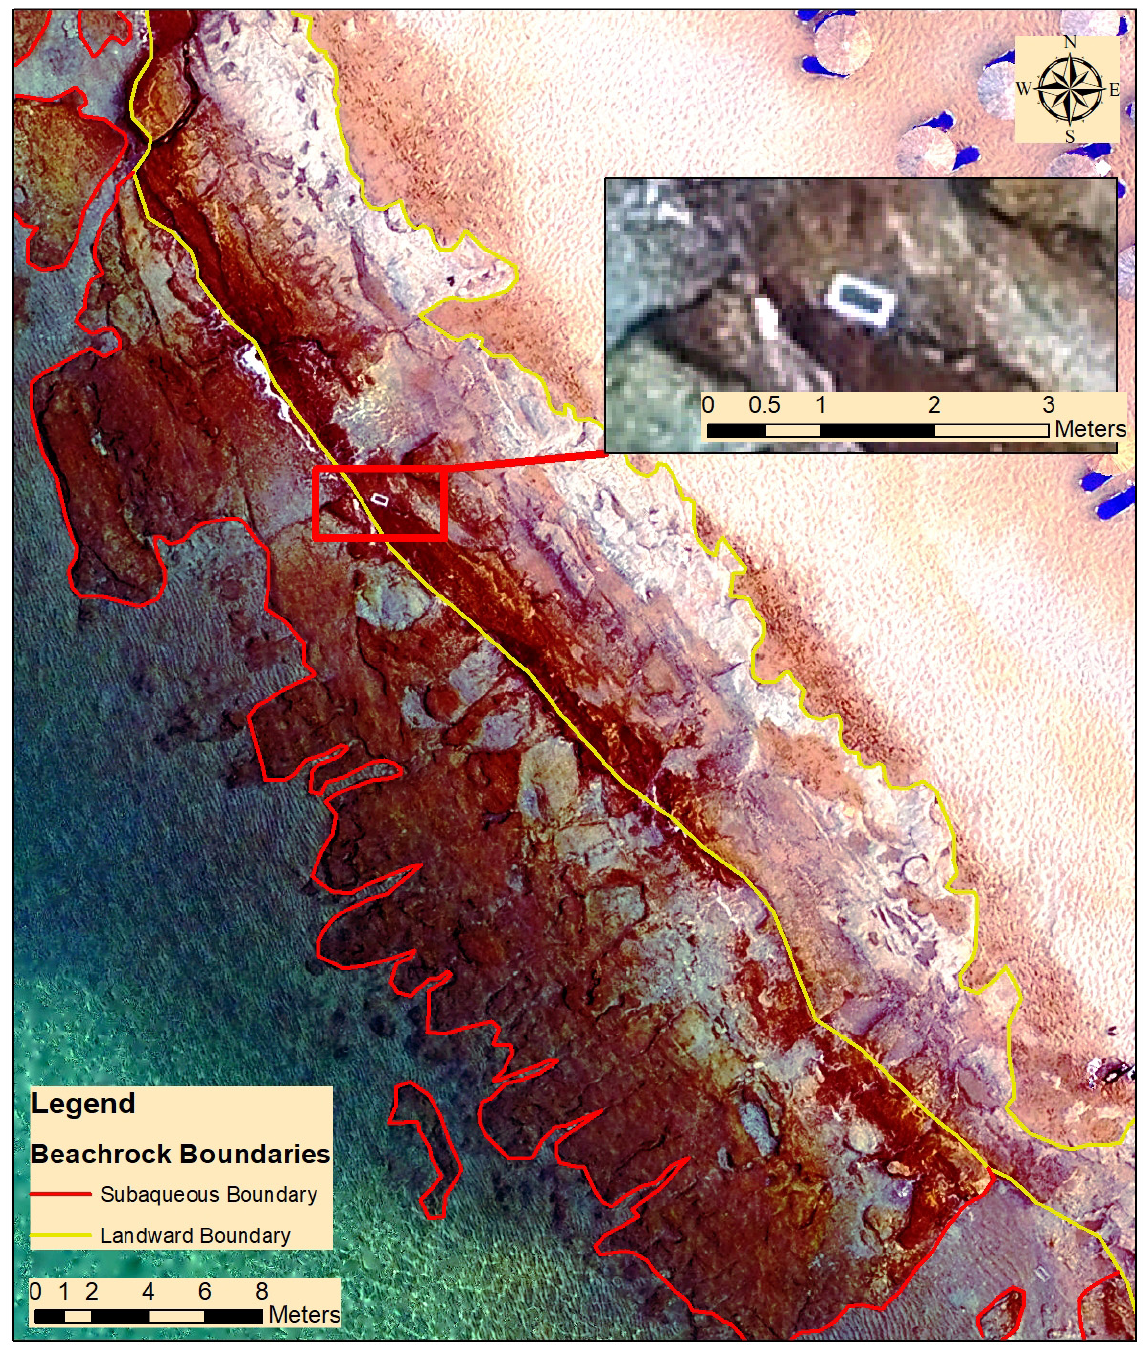
Figure 7. Orthophoto showing beachrocks of the second study area and the beachrock boundaries. At the inset you can see clearly one of the aluminum targets used for the accuracy